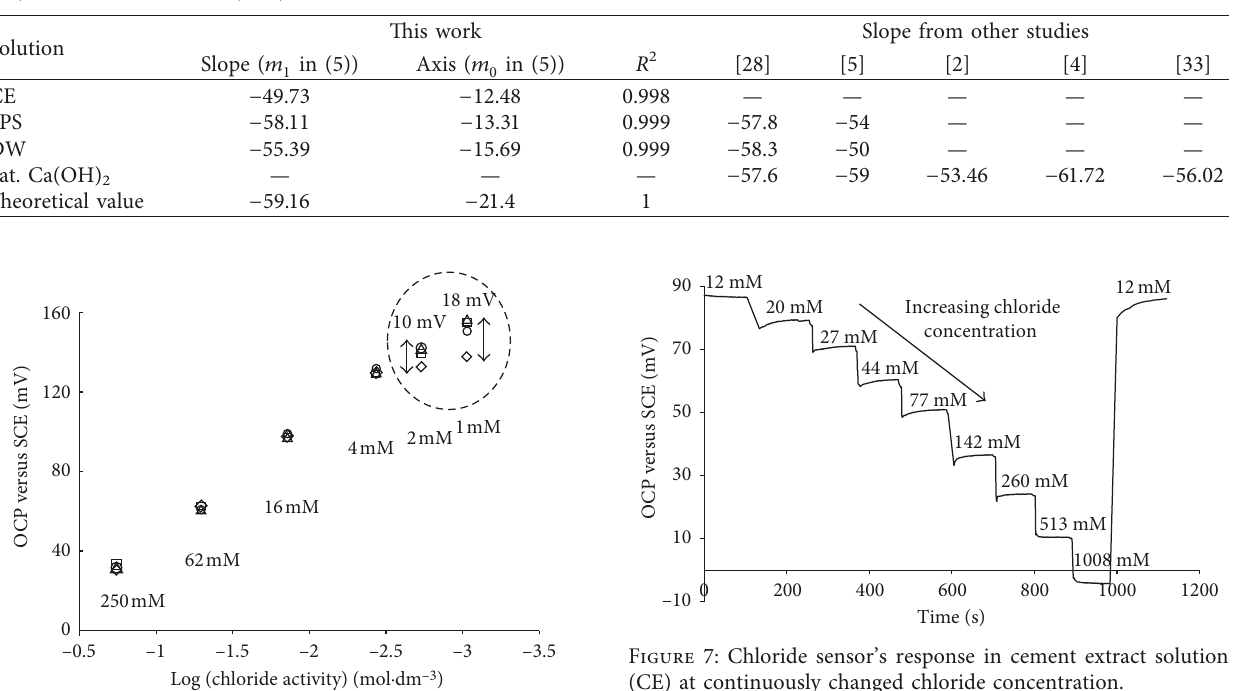
Table 3: Slope of the calibration curves and results from the statistical analysis in simulated pore solution (SPS), cement extract solution (CE), and deionized water (DW).